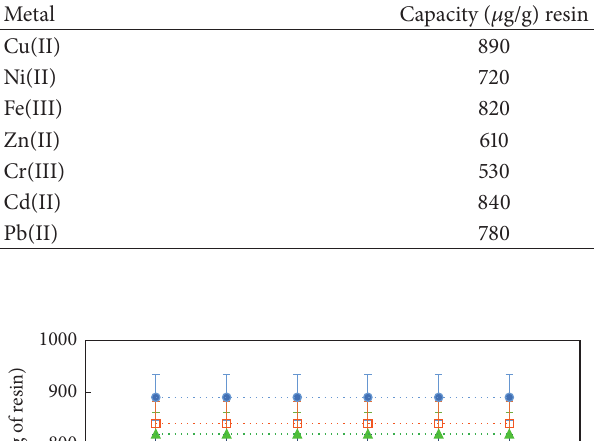
Figure 2: Effect of flow rates of sample solution on the retentions of analytes (pH = 7.5; amount of metal ions: 30 𝜇 g Pb(II) and Cr(III), 20 𝜇 g Fe(III), 15 𝜇 g Cu(II) and Ni(II), and 10 𝜇 g Cd(II) and Zn(II); CR amount: 1.0mmol/L; amount of resin: 0.5 g; final volume: 5 mL and 𝑁 = 3 ).